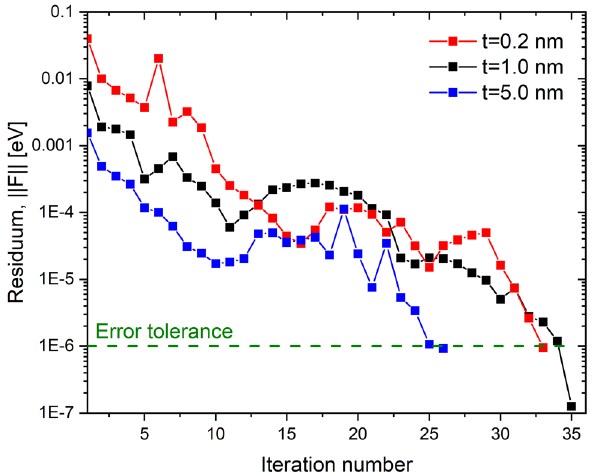
Figure 10. Convergence evaluation of the method. The convergence rate of the charge self-consistent open- system Schrodinger-Poisson equations for different δ -layer thicknesses (t) is